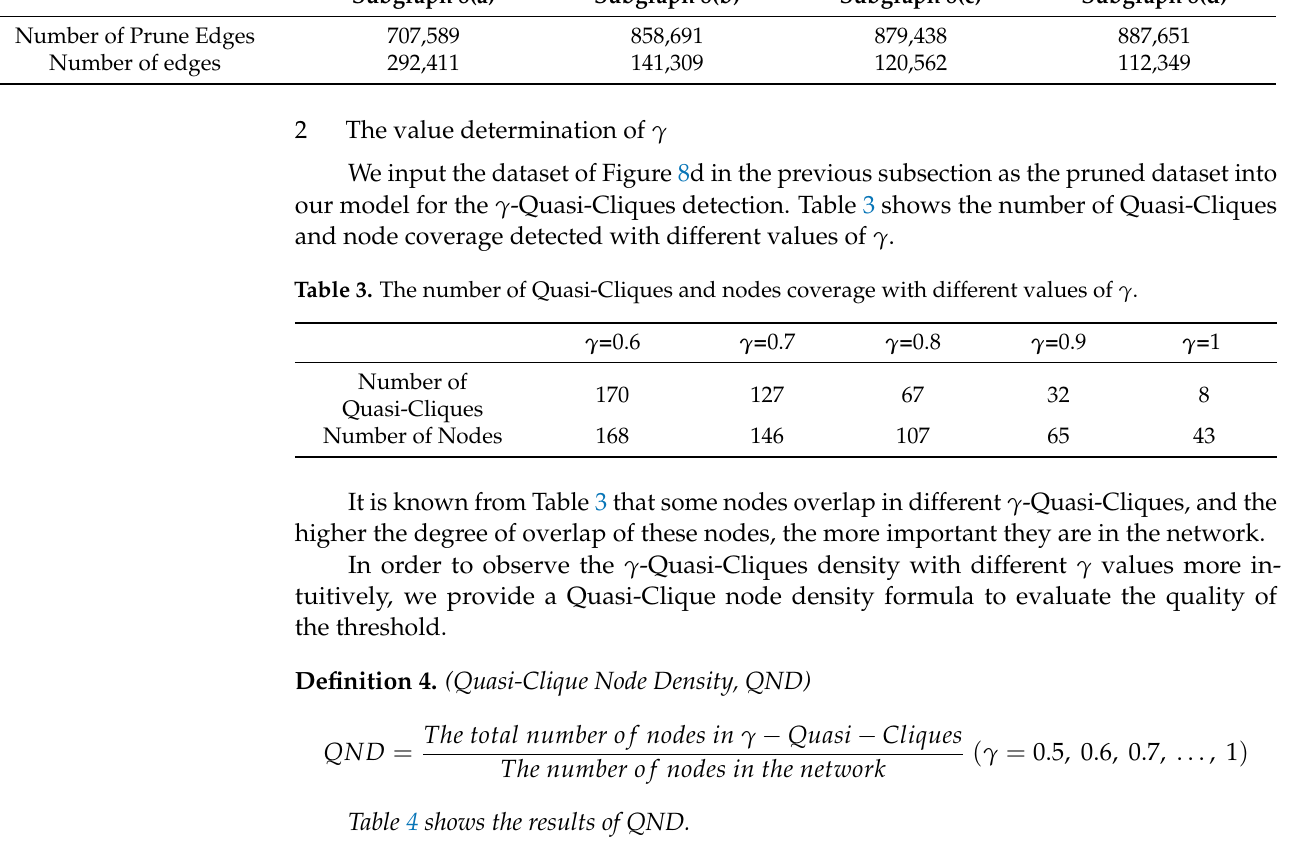
Table 4. The number of QND with different values of γ . γ = 0.6 γ =